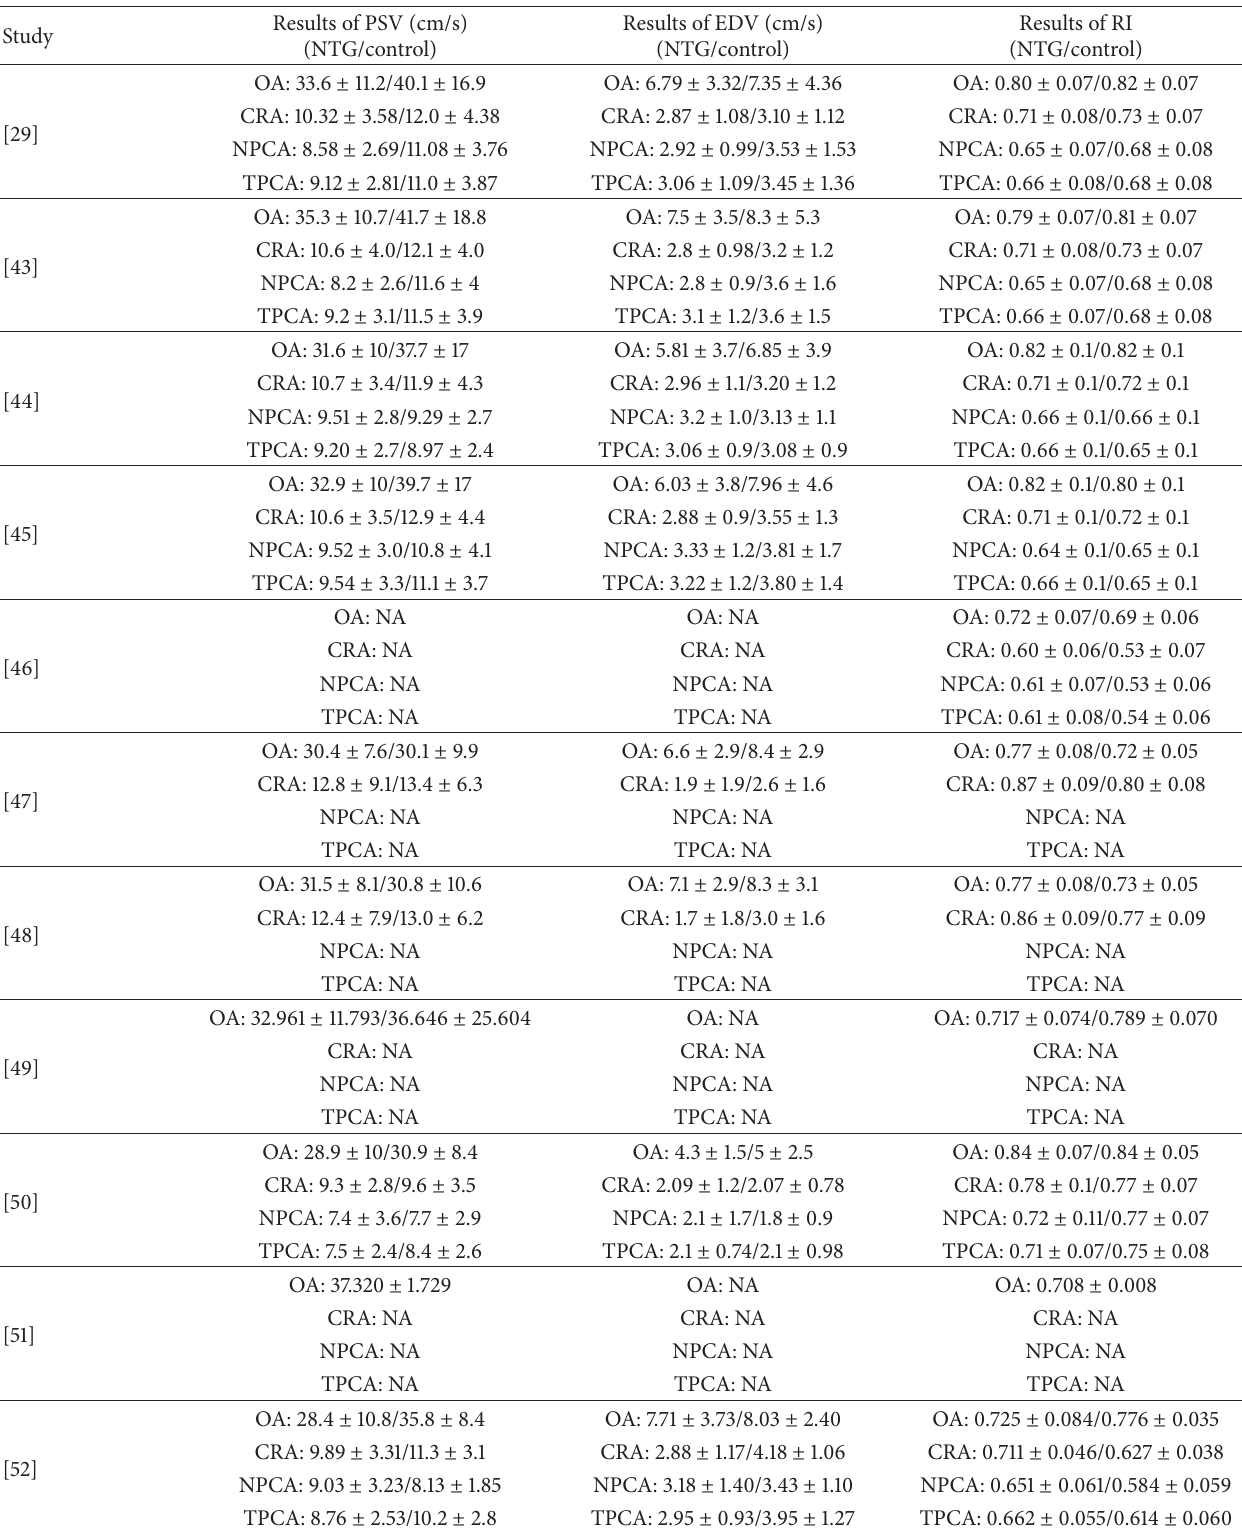
Table 5: Outcome measures data of the included